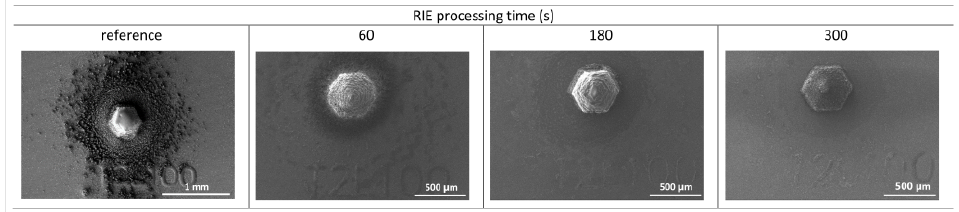
Figure 7. Removal of the over-spray by RIE with different processing times for a pillar with 100 printed layers.